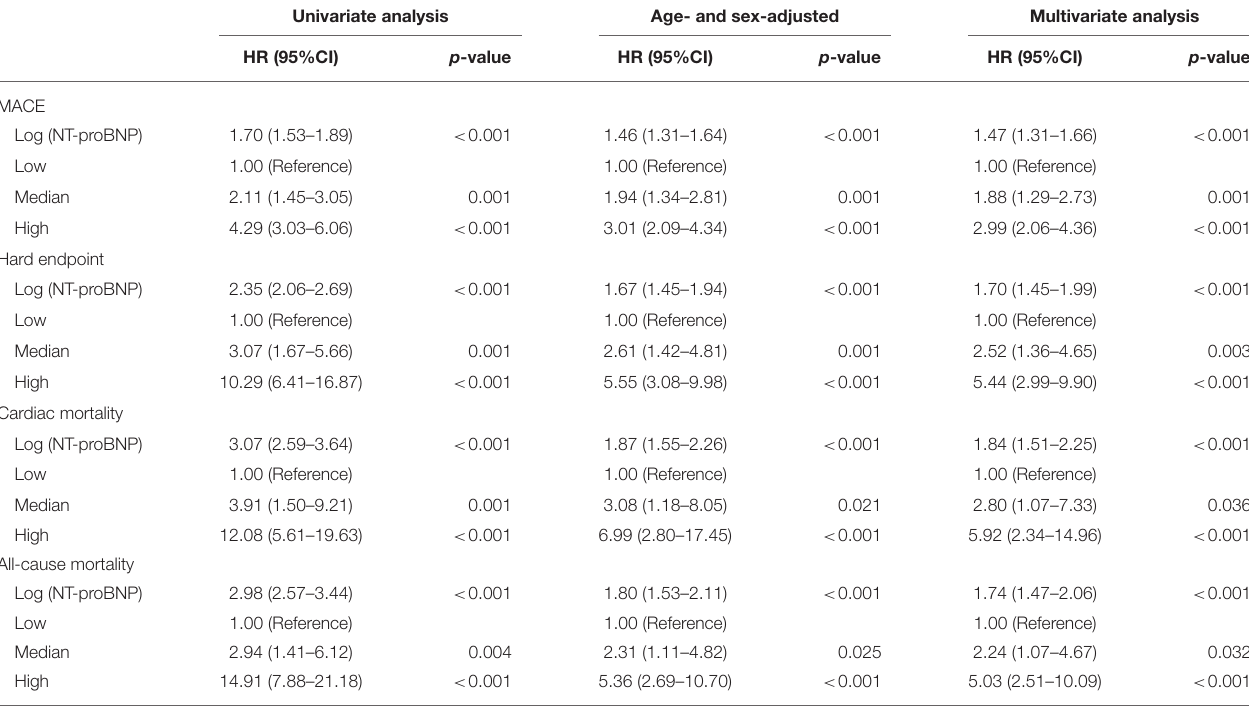
TABLE 2 | Univariate and multivariate Cox proportional hazards regression analyses of NT-proBNP for predicting cardiovascular events. Univariate analysis Age- and sex-adjusted Multivariate